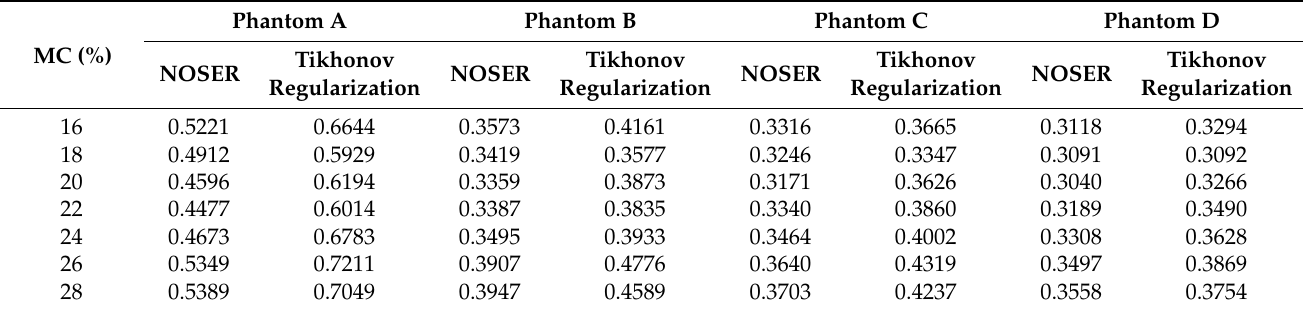
Table 8. MSSIM Indexes computed on the reconstructed